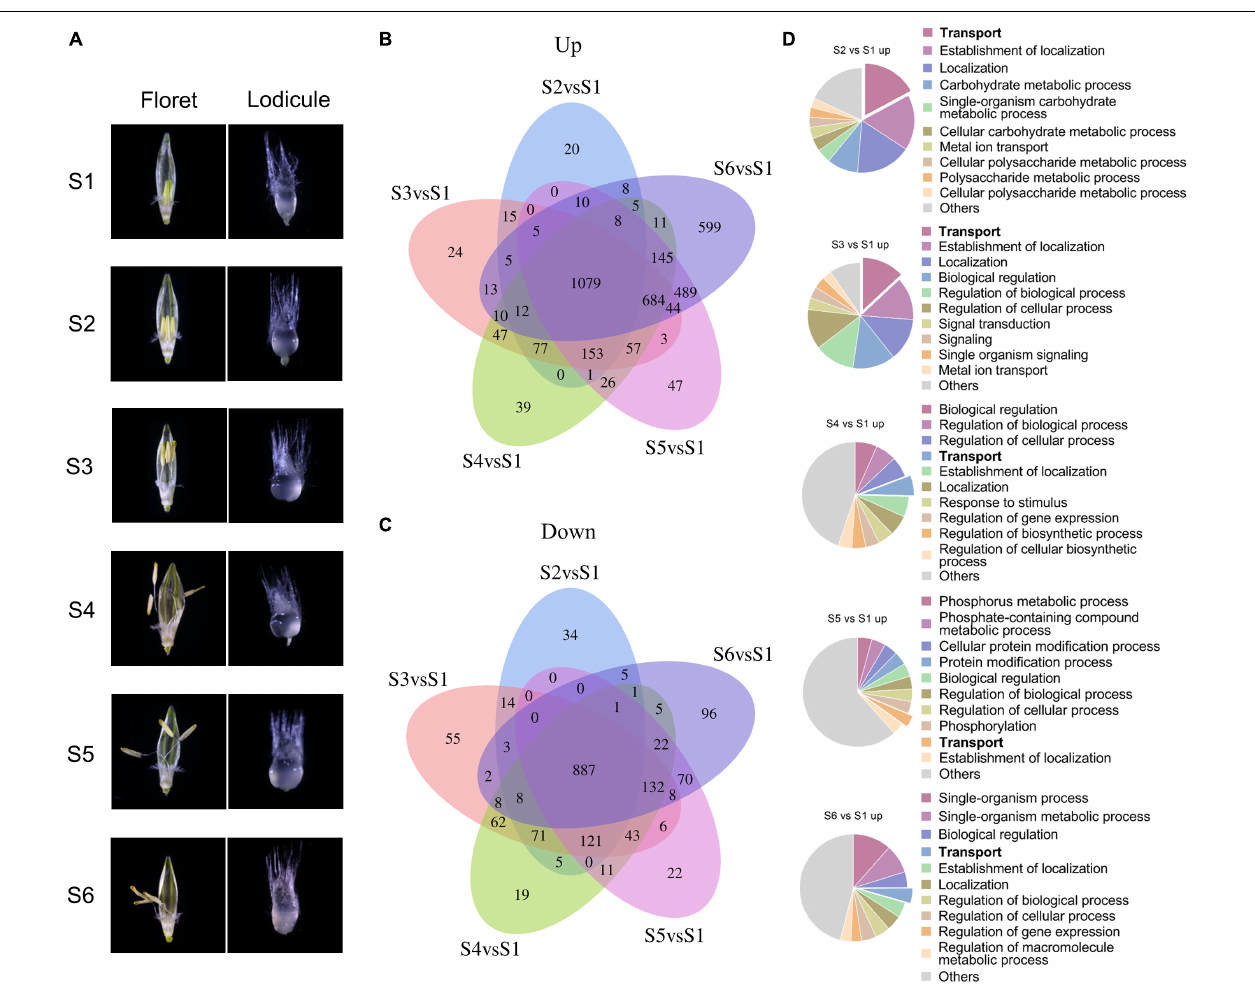
FIGURE 2 | Transcriptomic analysis of differentially expressed genes during the glume opening and closing process. (A) Morphology of floret (left panel) and lodicule (right panel) at six stages (S1–S6) of flowering in barley. S1: the prior stage to glume opening with the green immature anthers and the small thin lodicules; S2: the initial stage of glume opening with the yellow mature anthers and the large thick lodicules; S3: the median stage of glume opening with half-elongated filaments (in the median space of the glumes) and half-enlarged lodicules; S4: the maximum stage of glume opening with fully elongated filaments (out of the glumes) and fully enlarged lodicules; S5: the median stage of glume closing with dehiscent anthers and dehydrating lodicules; and S6: the final stage of glume closing with pale anthers and fully dehydrated lodicules. Venn diagrams of upregulated (B) and downregulated (C) DEGs with | log 2 foldchange | ≥ 1 and FDR < 0.05. (D) Gene Ontology analysis of upregulated DEGs was considered statistically significantly enriched when FDR < 0.05. All Go terms are listed in Supplementary Dataset 1